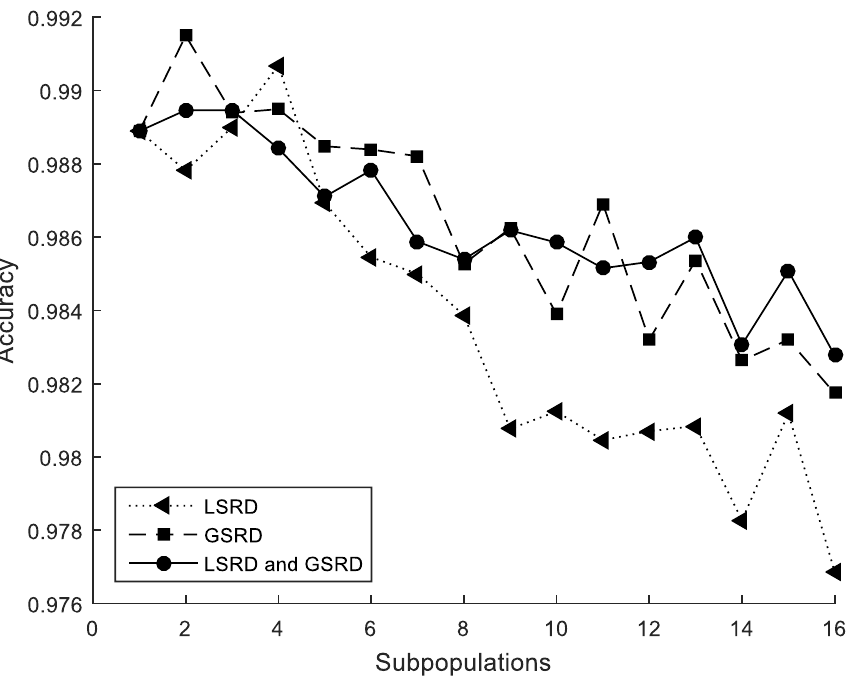
Figure 12. Cross-section under biaxial bending. Accuracy.